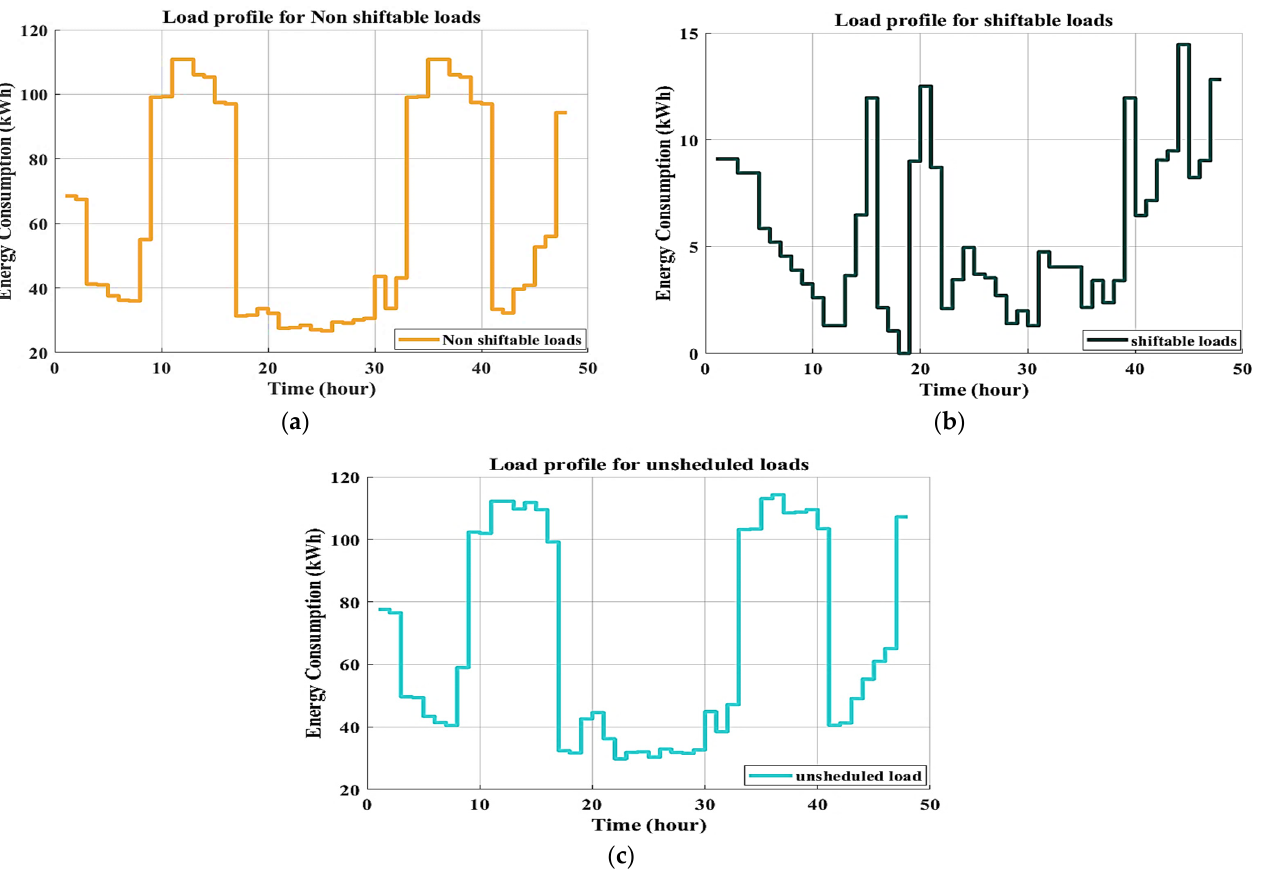
Figure 6. Load profile for ( a ) non-shiftable loads, ( b ) shiftable loads, and ( c ) unscheduled loads.